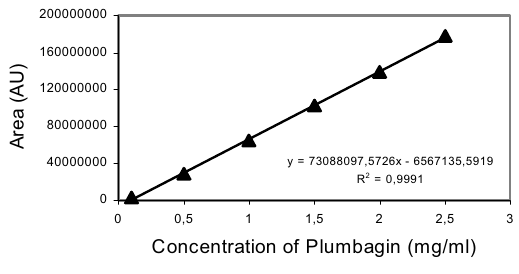
Fig. 2 – Standard curve with known concentration of plumbagin.